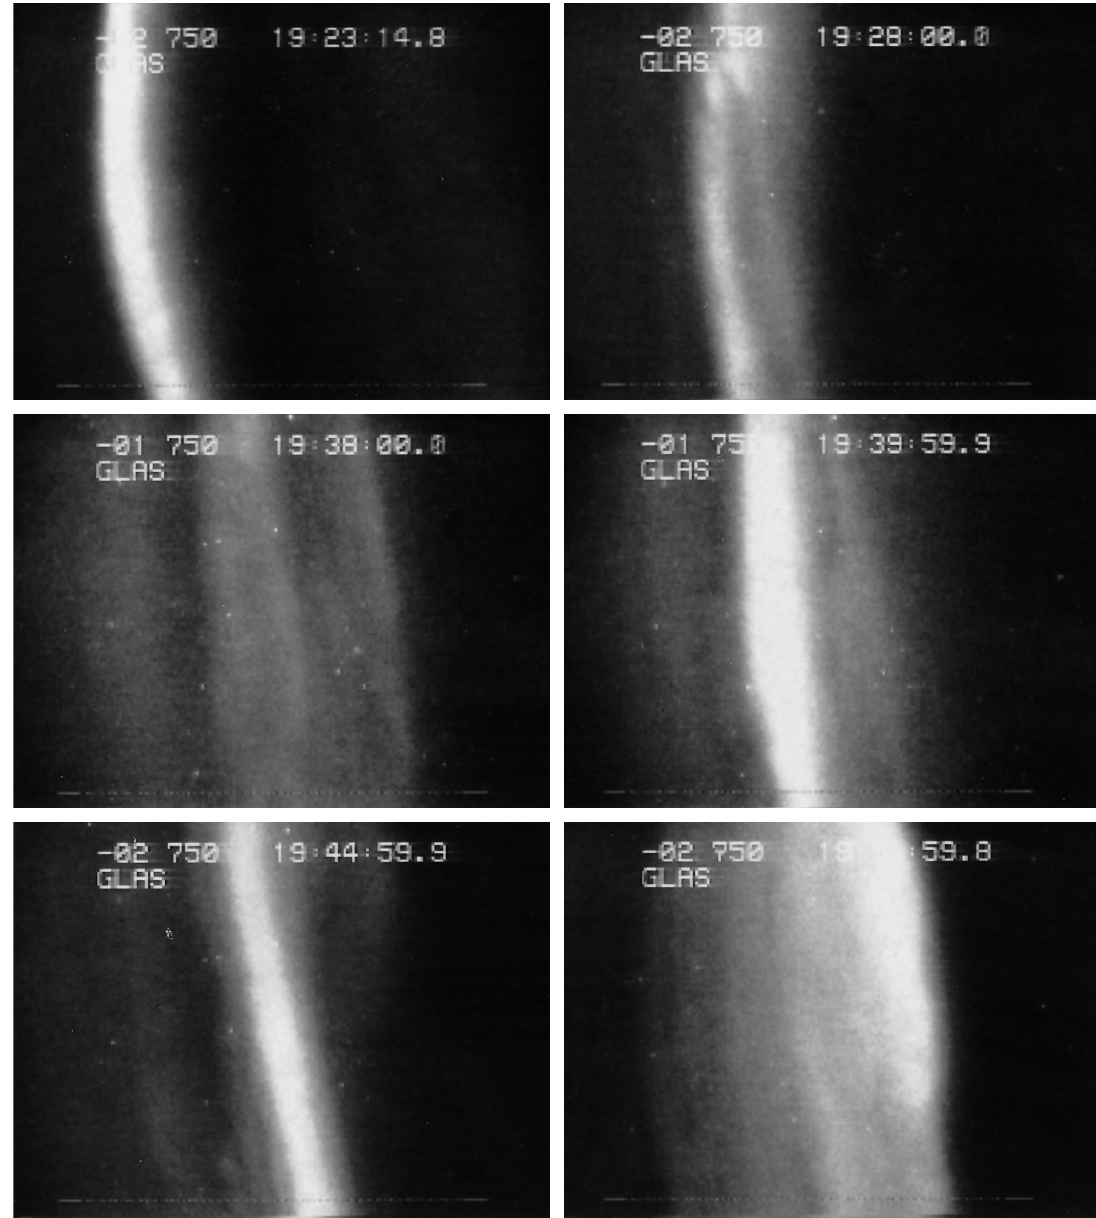
contrast enhanced. The integration time of the images at 19:38 and 19:40 is twice the integration time of all other images (10